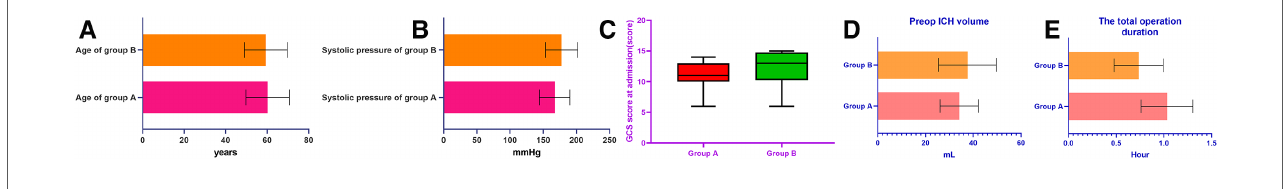
FIGURE 3 The histograms in the fi gure represent essential characteristics such as age, systolic blood pressure on admission, GCS score on admission, and preoperative hematoma volume, as well as the comparison results of the average operative time between the two groups, respectively.